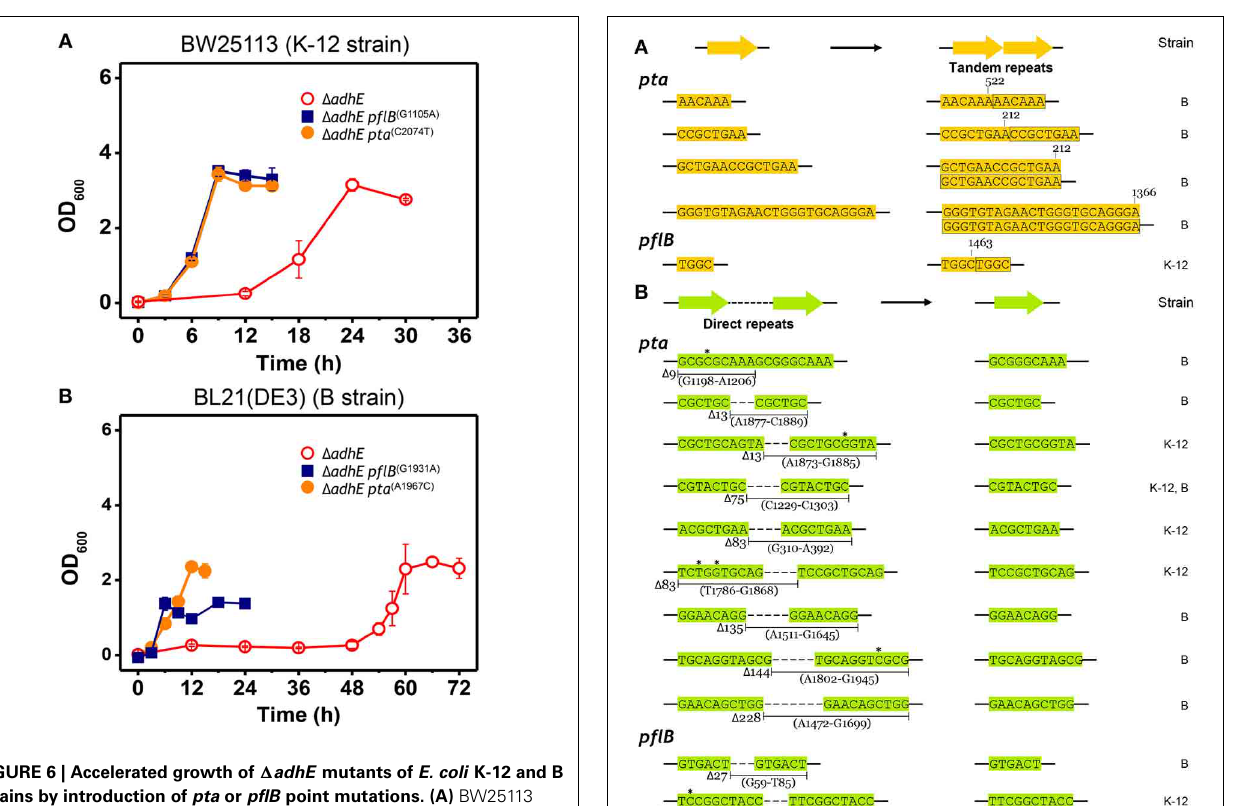
indicated that (cid:2) adhE mutant cells underwent severe anaerobic stress, whereas the adapted mutant cells survived. The aerobic- to-anaerobic transition ability and the viability of K-12 cells were superior to those of B cells under anaerobic stress